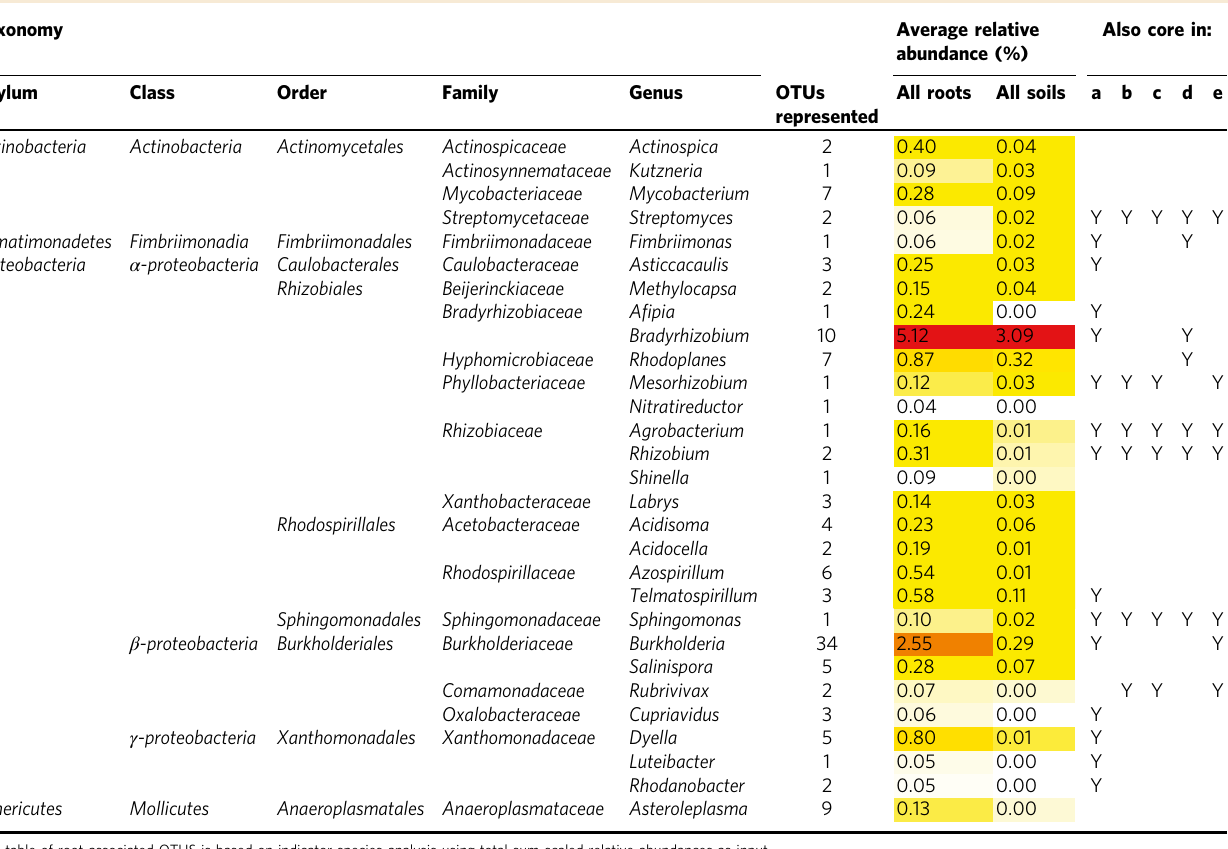
This table of root-associated OTUS is based on indicator species analysis using total sum-scaled relative abundances as input. “ Y ” represents “ yes ” for the fi ve rightmost columns under “ Also core in ” . a: sugarcane 8 , Australia; b: A. thaliana 1 , Germany; c: barley 5 , Germany; d: grapevine 60 , America; e: maize 3 , America. Please see Supplementary Table 3 for full table showing relative abundances by individual plant phyla and OTUs without genus classi fi cation. Please see Supplementary Tables 4 and 5 for list of root-associated OTUs based on STAMP and sPLSDA, respectively.